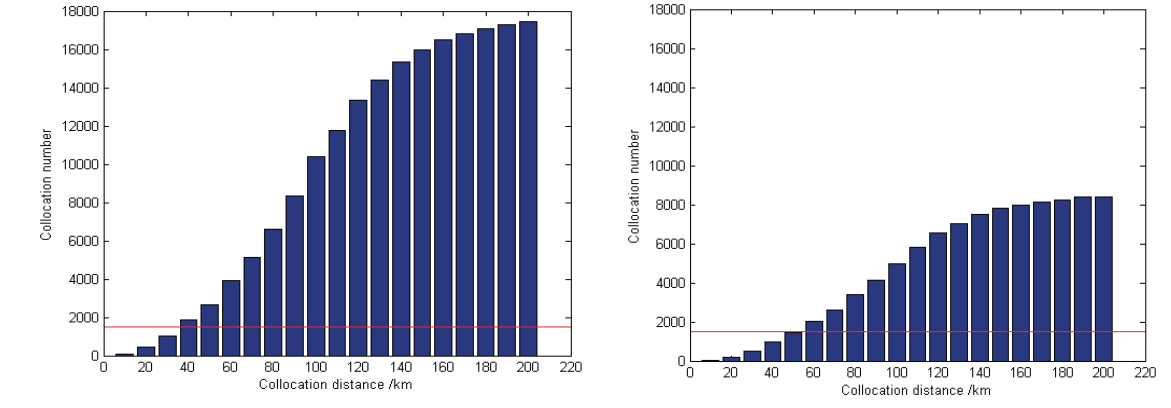
Figure 4. Histograms of triple collocation numbers with the all buoys ( left ), and those in the deep and open ocean ( right ). The red lines represent the collocation numbers of